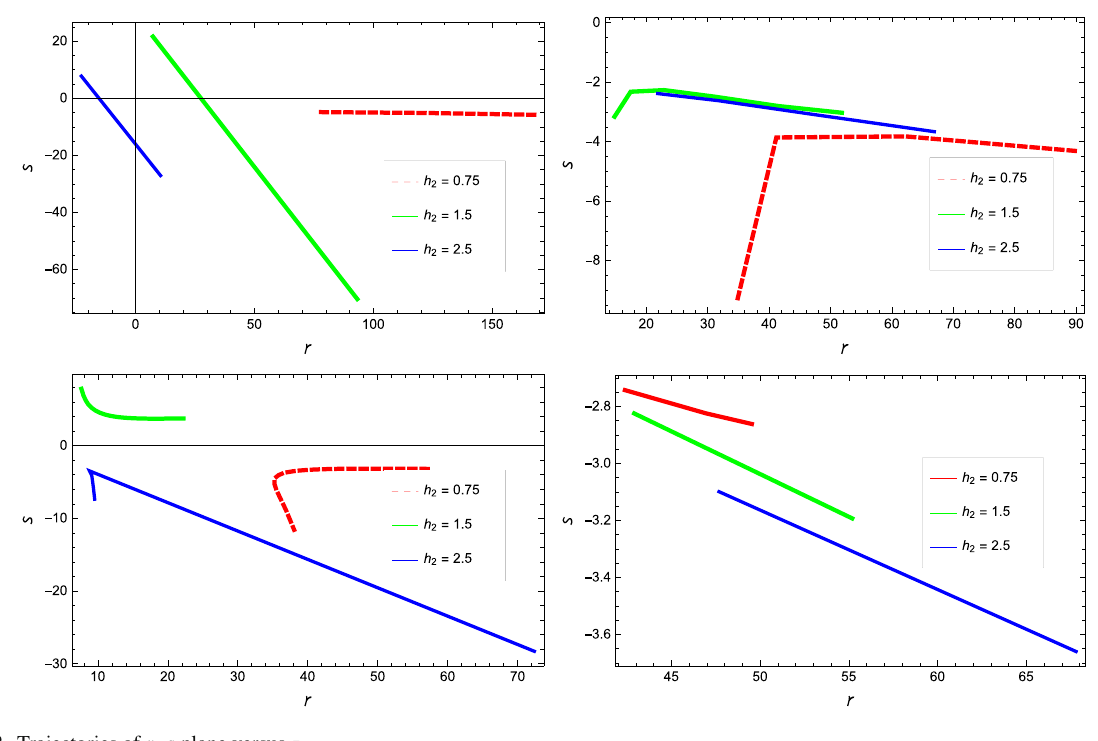
Fig. 12 Trajectories of r – s plane versus z ω – ω (cid:2) plane locates thawing region. For open universe model with positive PDE parameter (lower left plot), the graphical interpretation corresponds to thawing region for all chosen values of h 2 whereas in the right plot, freezing and thawing regions exist for h 2 = 0 . 75 and h 2 = 1 . 5 , 2 . 5, respectively. Figure12measuresthecompatibilityofGGPDE f ( R ) model with standard cosmological models through r – s